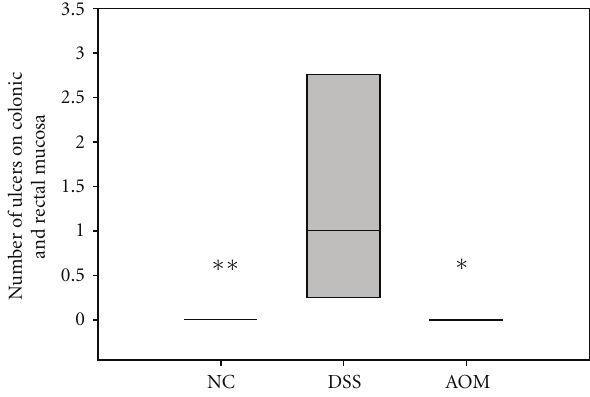
Figure 10: Number of ulcers of colonic and rectal mucosa in di ff erent treatment groups. DSS 1.0 (0.5–2.5); AOM 0.0; NC 0.0. ∗∗ Denotes P ≤ 0 . 01 and ∗ denotes P < 0 . 05 compared to the DSS